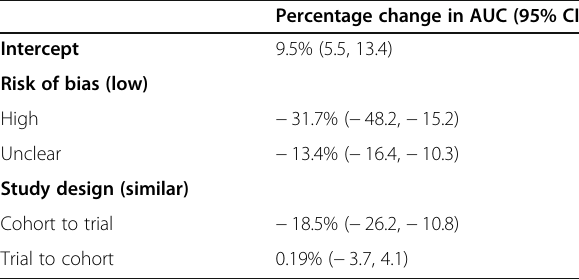
Table 4 Results of generalized estimated equations (GEE) for the percentage change in AUC between 10 development